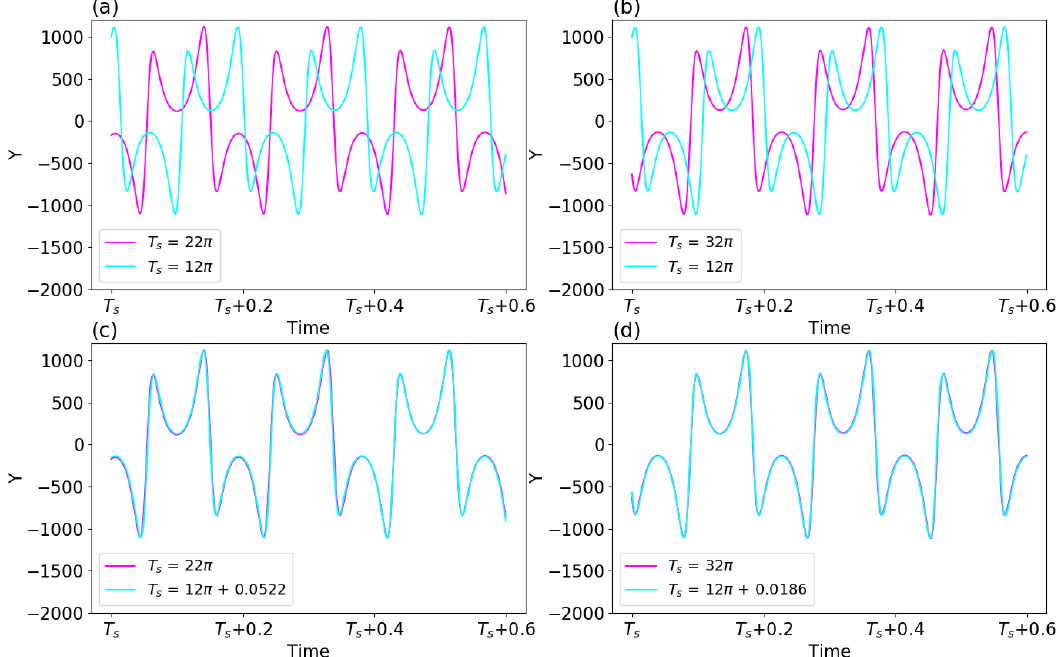
Figure 7. Panels ( a , b ) display the same trajectory during three different time intervals of τ ∈ [ Ts , Ts + π ], with the starting time Ts equal to 12π, 22π, and 32π, respectively. These three time intervals are referred to as Epoch-1, Epoch-2, and Epoch-3, respectively. In panels ( c , d ), to adjust the phase differences between two solutions curves, a time lag is added into Epoch-1.